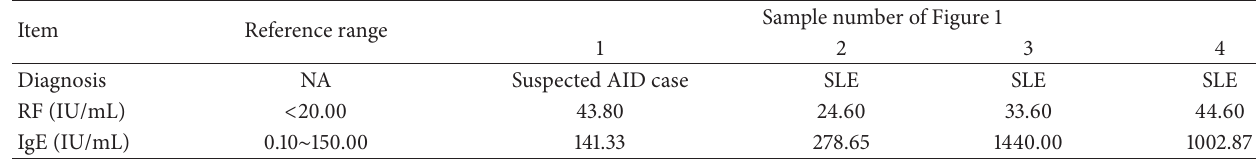
Table 2: Some laboratory data of SLE family cases enrolled in this study.